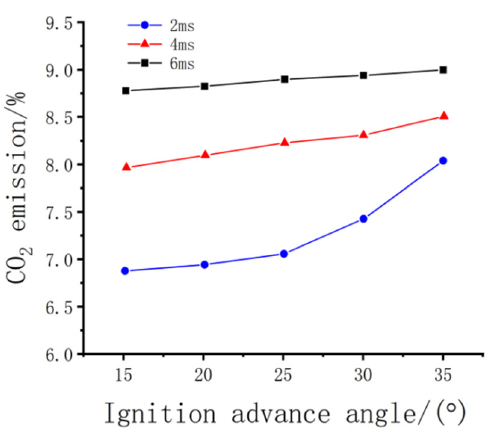
Figure 24. Effect of the ignition parameters on CO 2 emissions.